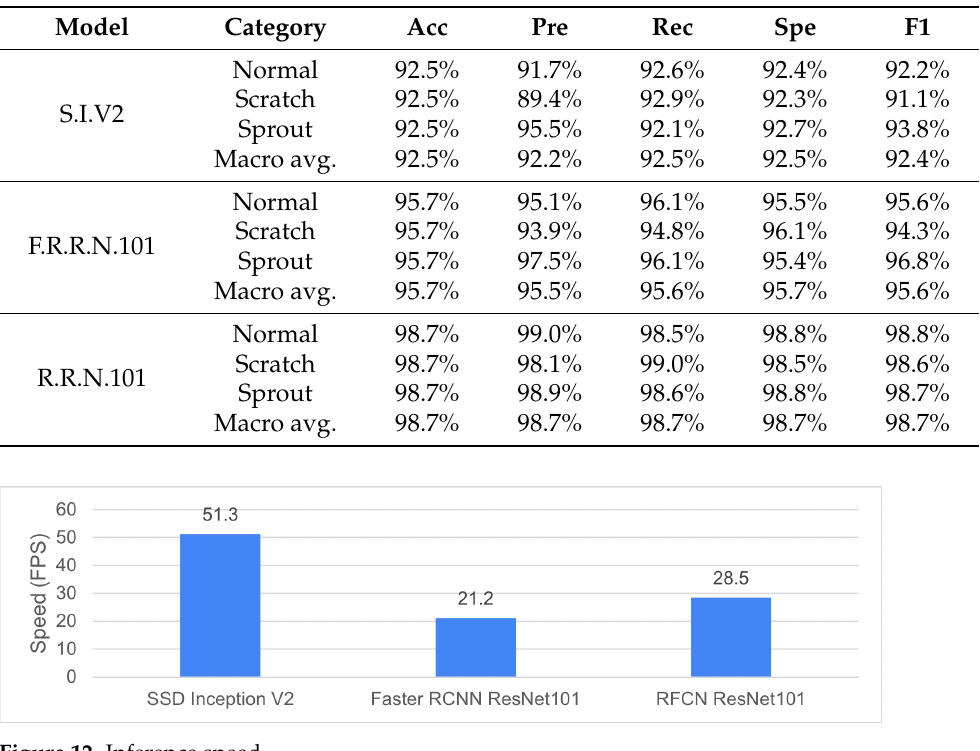
Table 3. Model performance on the test set. Abbreviations: S.I.V2 = SSD Inception V2; F.R.R.N.101 =